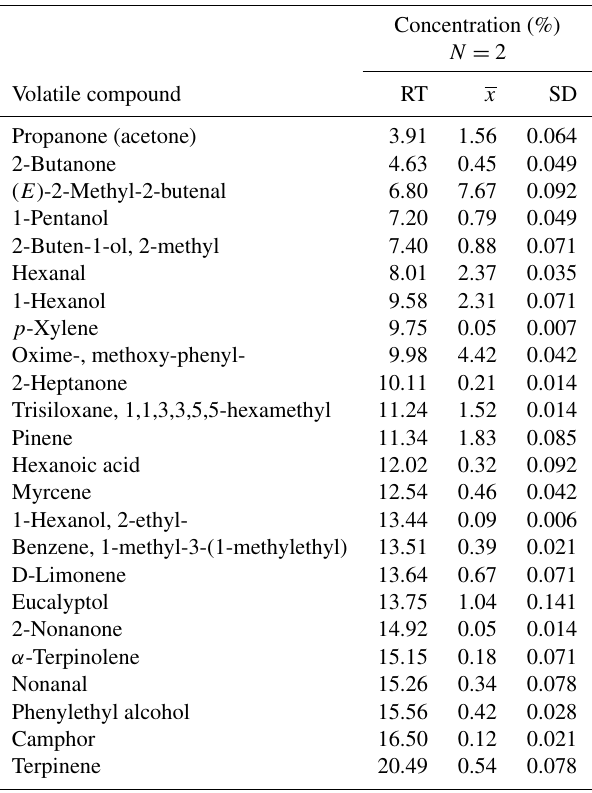
The abbreviations used in the table are as follows: RT – retention time and SD – standard